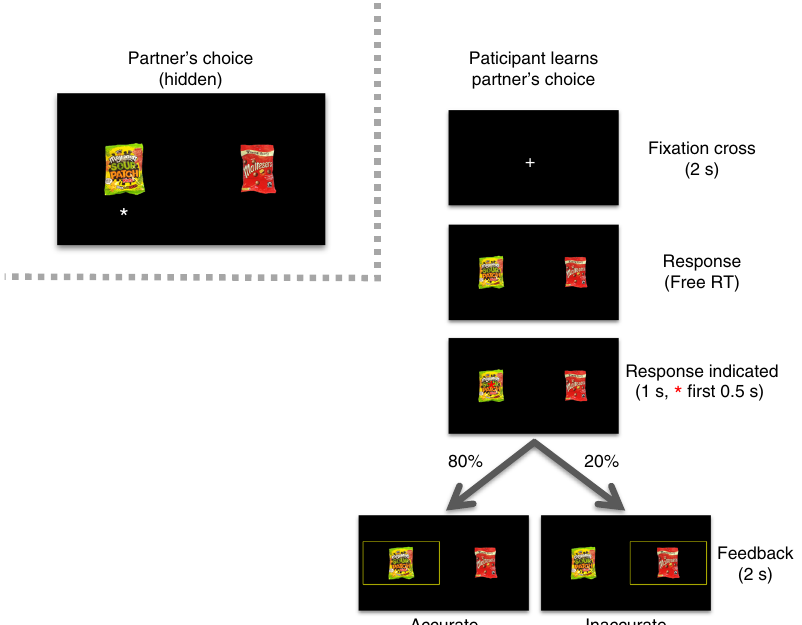
Fig. 1 Learning task. Participants were asked to indicate which choice they believed their partner made. After making a response, a yellow feedback box indicated the correct answer with 80% probability. Participants saw 20 different pairs, interleaved, 30 times each for a total of 600